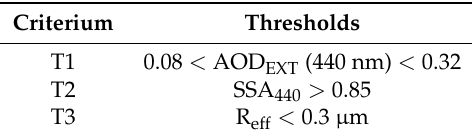
Table 1. Criteria of the “screening scheme” performed in this work, based on thresholds applied to AERONET AOD EXT (440 nm), SSA (440 nm) and R eff , to remove data affected by the presence of layers of absorbing aerosol in the atmospheric column, namely desert dust and fire plumes.